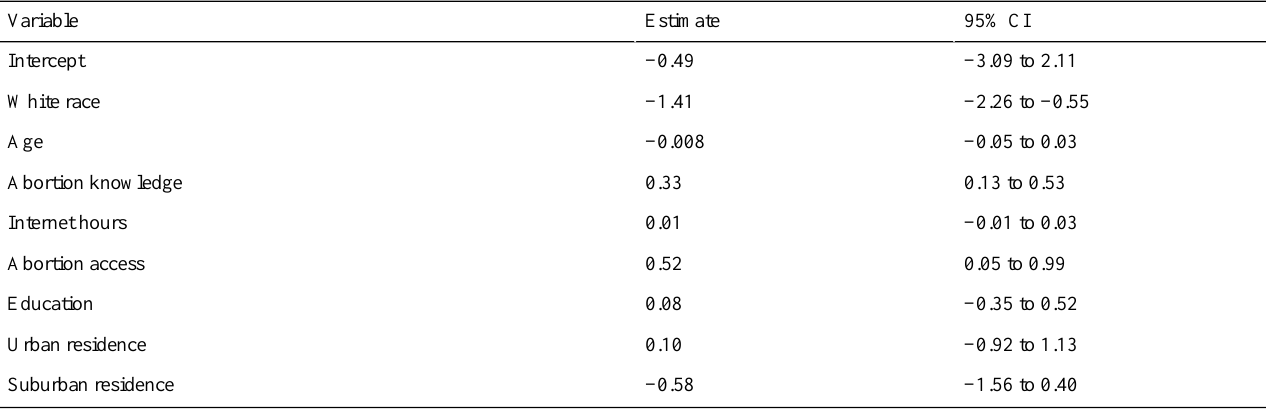
Table 8. Association between individual demographic factors and the primary outcome of mean overall trust (N=462) for all websites except the Louisiana